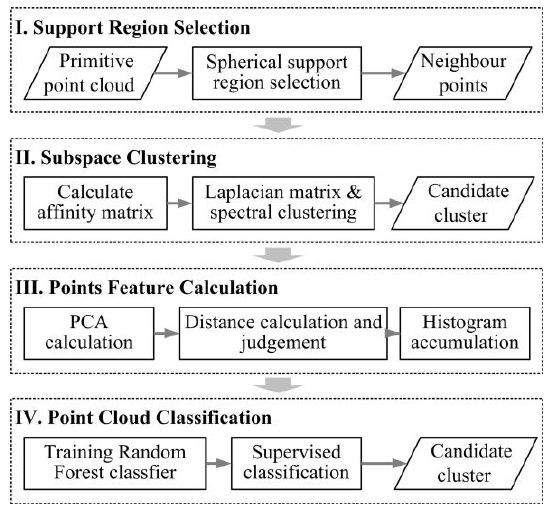
Figure 2. The overall